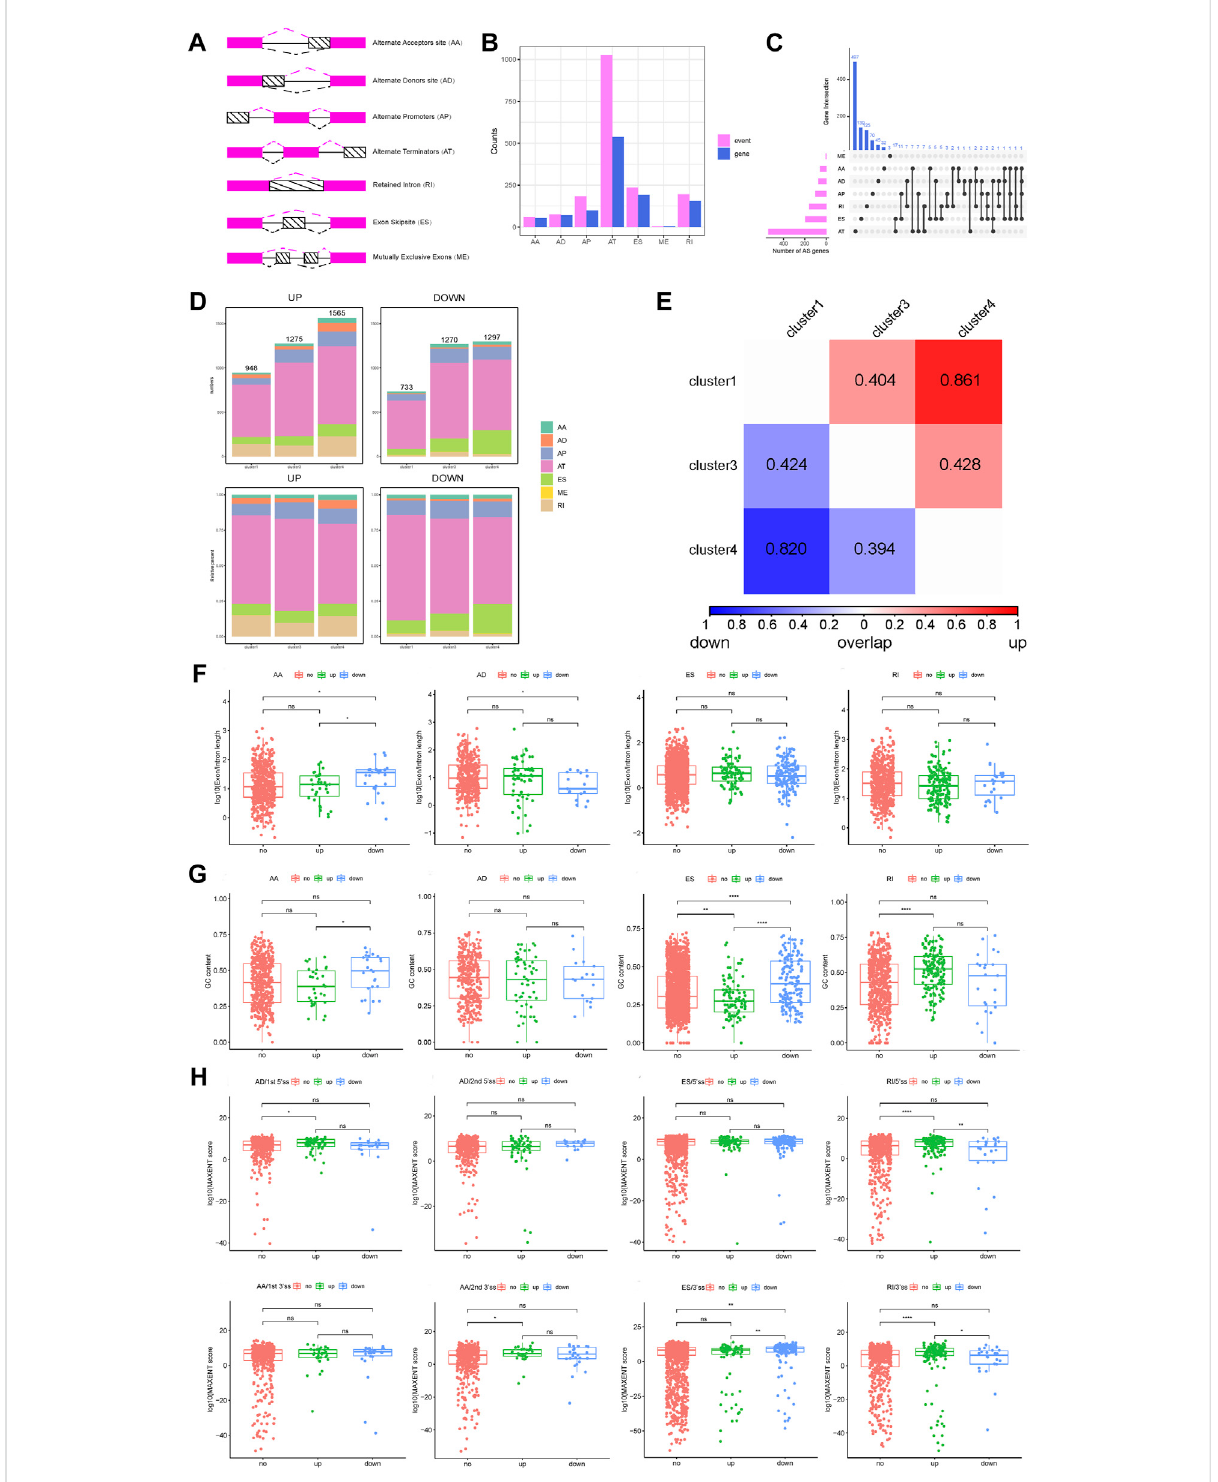
FIGURE 2 Analysis of DASEs and DASEs between subtypes and alternative splicing fragmentlength and score of the overall DASEs. (A) Schematicdiagram of alternative splicing types. (B) Statistics of the number of splicing types of DASEs and corresponding gene splicing types. (C) UpSet diagram of the different alternative splicing types of DASEs corresponding genes. (D) Statistics of alternative splicing types of DASEs of each subtype. (E) Overlap similarity of DASEs up and down between subtypes. (F) Alternative splicing fragment length of overall DASEs. (G) GC content of overall DASEs. (H) Alternative splicing score for overall